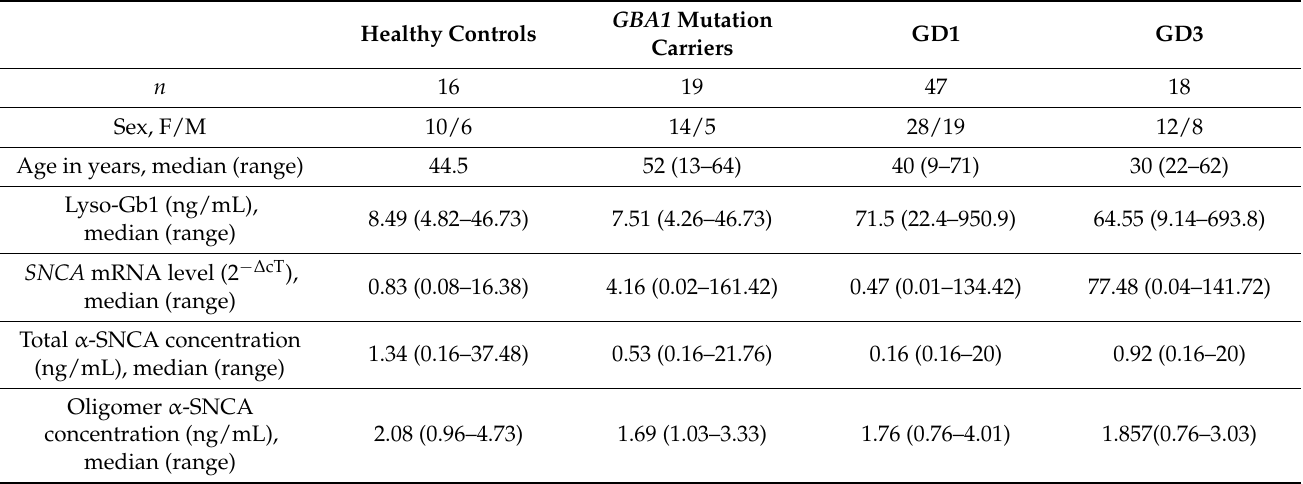
Table 2. Patients’ characteristics. Abbreviations: α -SNCA—alpha-synuclein; GD—Gaucher disease; Lyso-Gb1—Glucosylsphingosine; SNCA —gene coding